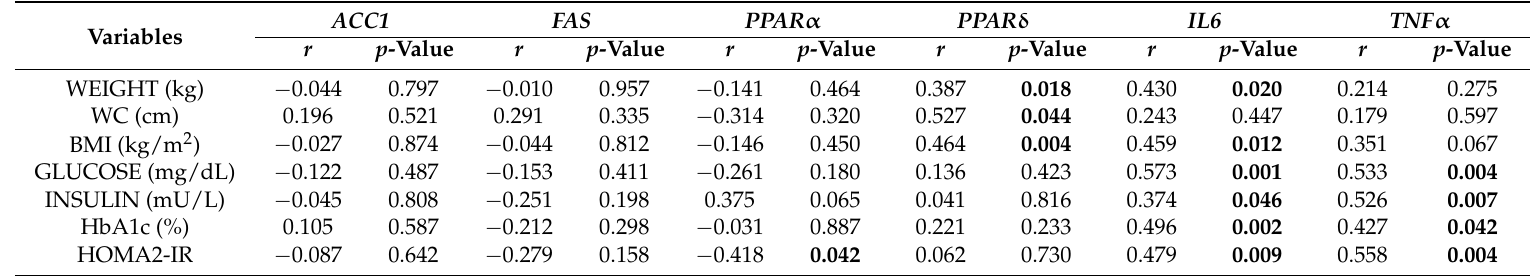
Table 2. Correlations of visceral mRNA expression of genes involved in fatty acid metabolism and inflammation with anthropometric and glucose metabolism parameters.